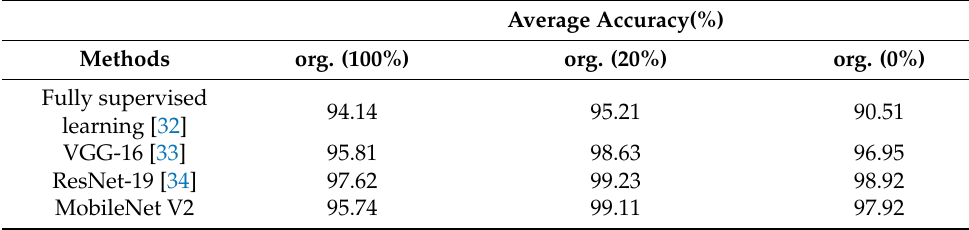
Table 3. Comparisons of different defect